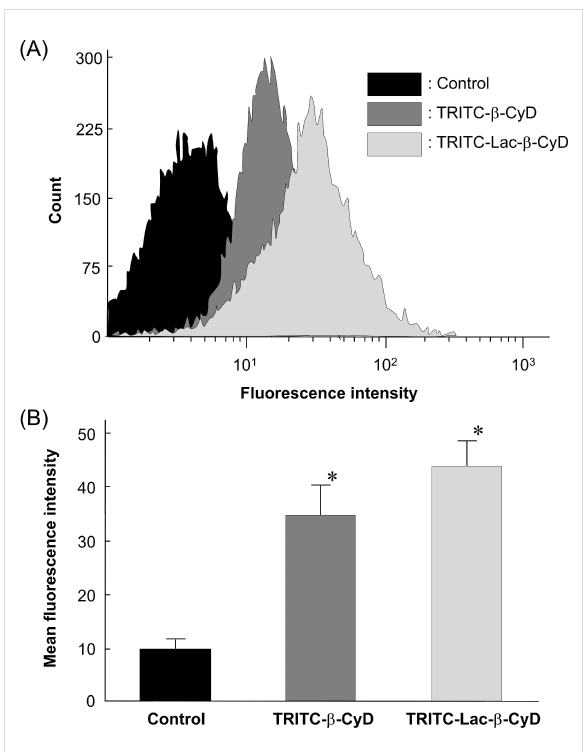
Figure 4: Cellular association of TRITC-Lac- β -CyD in U18666A- treated HepG2 cells after treatment for 24 h. The fluorescence inten- sity of TRITC in cells was determined 24 h after incubation at 37 °C by a flow cytometer. (A) The experiments were performed independently three times, and representative data are shown. (B) The fluorescent intensity was quantified by CellQuest software. Each value represents the mean ± S.E.M. of 6 experiments. * p < 0.05, compared with